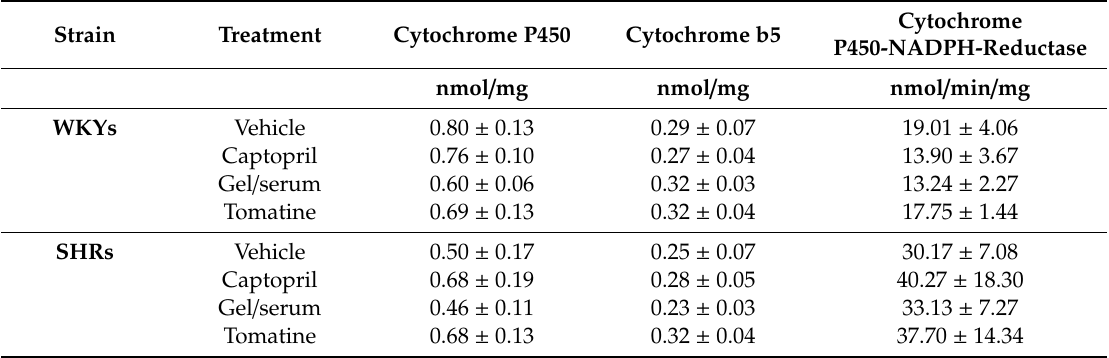
Table 5. Cytochrome content and cytochrome P450 reductase activity in liver microsomes obtained from treated WKYs and SHRs.